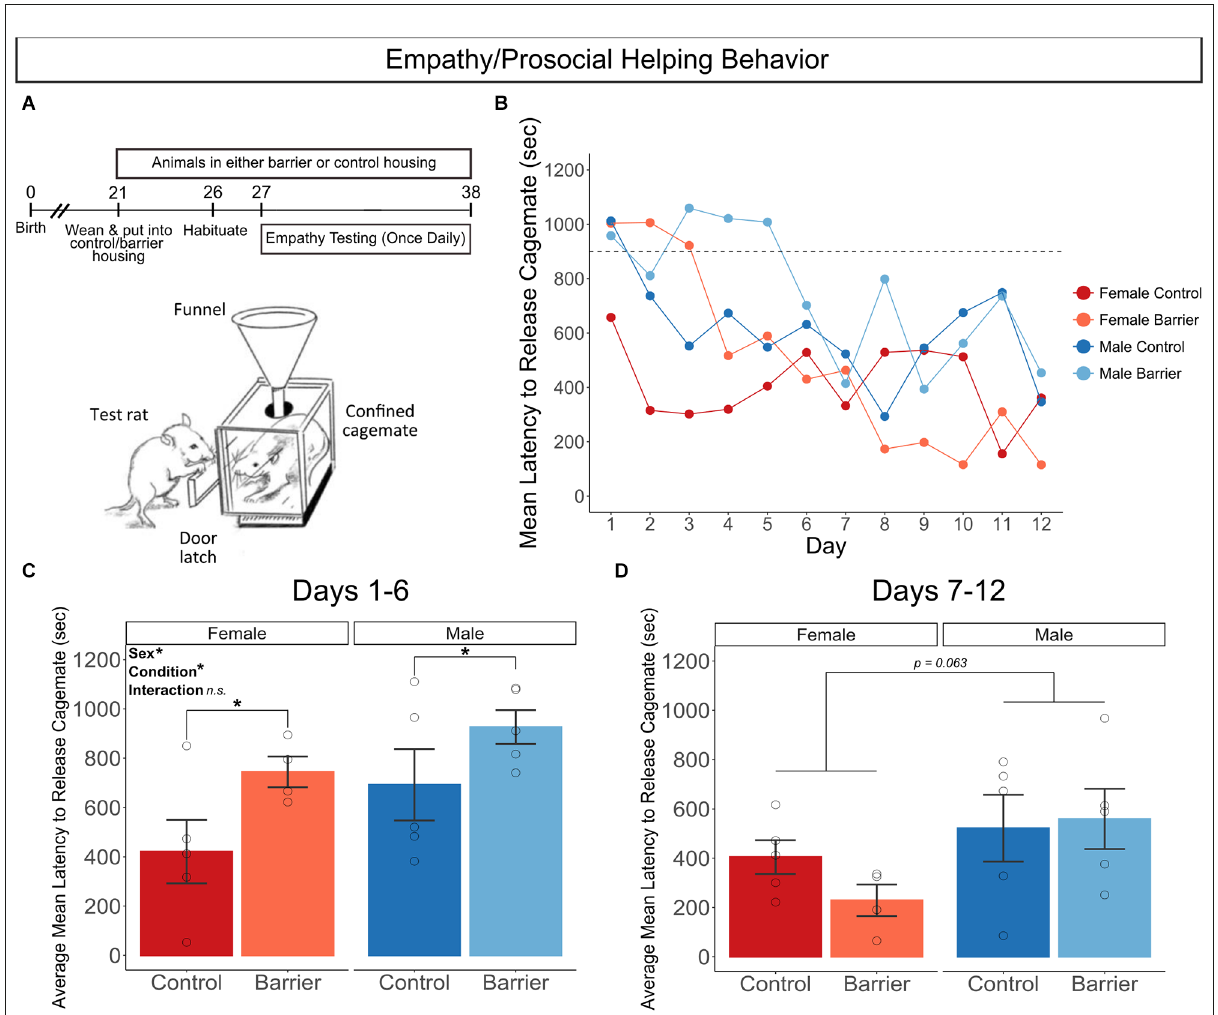
FIGURE10 Juvenile play deprivation impairs performance on a test of empathy/prosocial helping behavior. (A) Timeline of experiment and cartoon of the prosocial behavior test apparatus, showing the test rat opening the door latch to release its cagemate confined in the box. Quantification of the mean latency (in seconds) to release cagemate across the 12 days of testing (B) , with dashed line at 900 s indicating when the door latch was loosened by the experimenter if the test animal had not already released the confined cagemate. Quantification of the average mean latency to release cagemate across the first 6 (C) and the last 6 (D) days of the test procedure. Bars indicate group means ± SEM, and open circles represent data from individual rats. * p < 0.05, n = 4–5 per